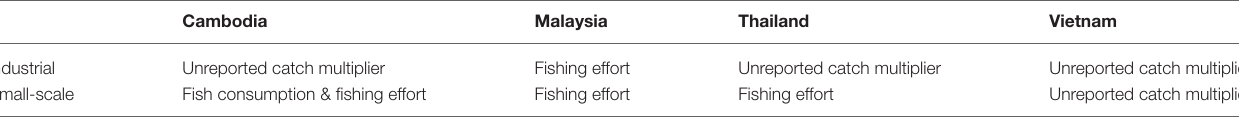
TABLE 2 | Methods for estimating unreported industrial and small-scale catch for each country.